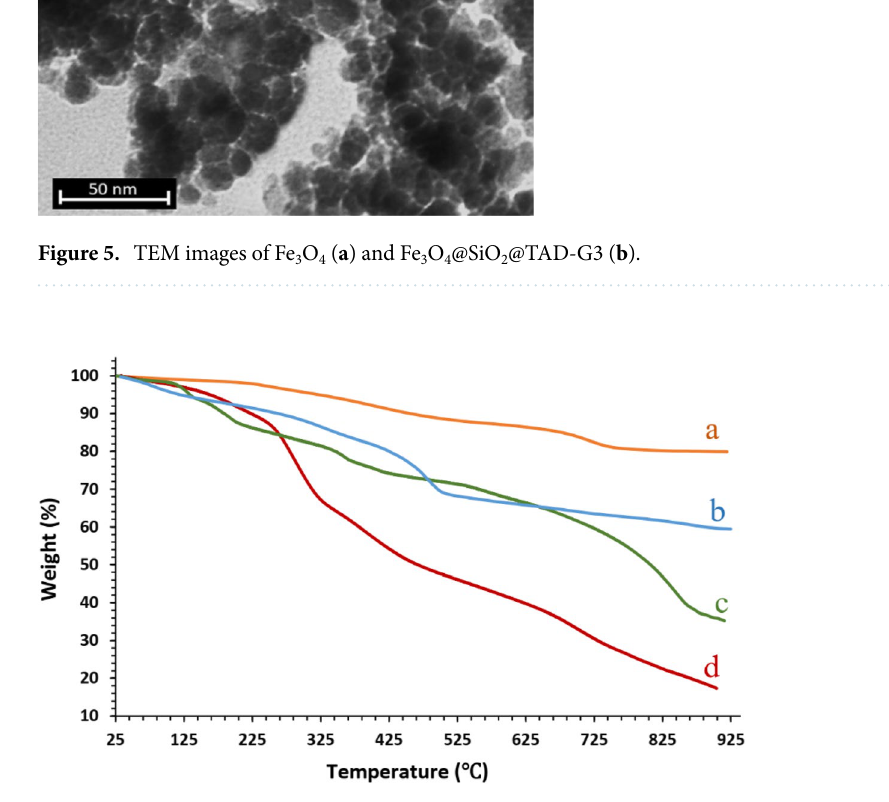
Figure 6. TGA analyses of Fe 3 O 4 @SiO 2 -PrNH 2 ( a ), Fe 3 O 4 @SiO 2 @D-G1 ( b ), Fe 3 O 4 @SiO 2 @D-G2 ( c ), Fe 3 O 4 @